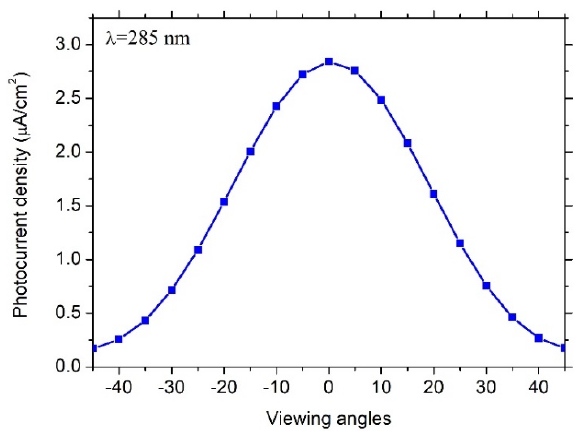
Figure 8. 4H-SiC photodiode photocurrent density at varying viewing angles.